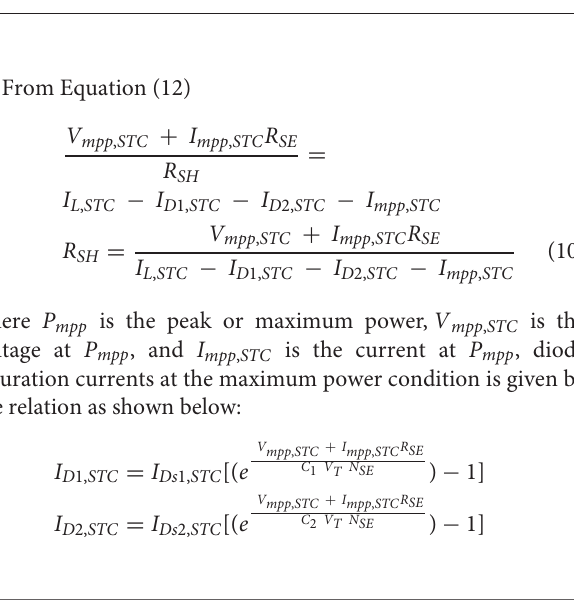
FIGURE 9 | Power (W) vs. voltage (V) curve of one-diode R SH for DS-A1-80 and MSX-64 at STC (25 ◦ C and 1,000 KW/m 2